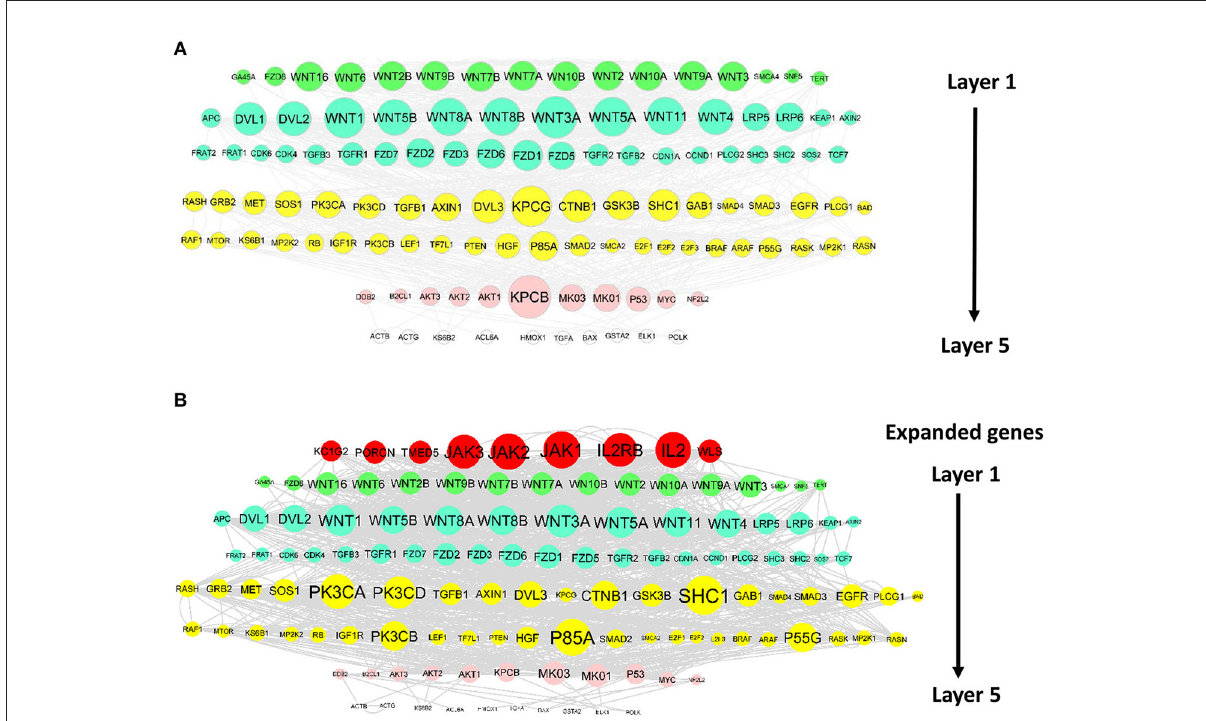
FIGURE7 WINNER upstream ranking and expansion can identify genes that are missing from established hepatocellular carcinoma networks. Genes in the KEGG hepatocellular carcinoma pathways were distributed into layers via WINNER upstream, and genes that were missing from the networks were identified via WINNER expansion. Genes in the same layer are displayed in the same color, and the size of the node represents the WINNER score. (A) WINNER ranking without expansion. (B) WINNER ranking with expanded